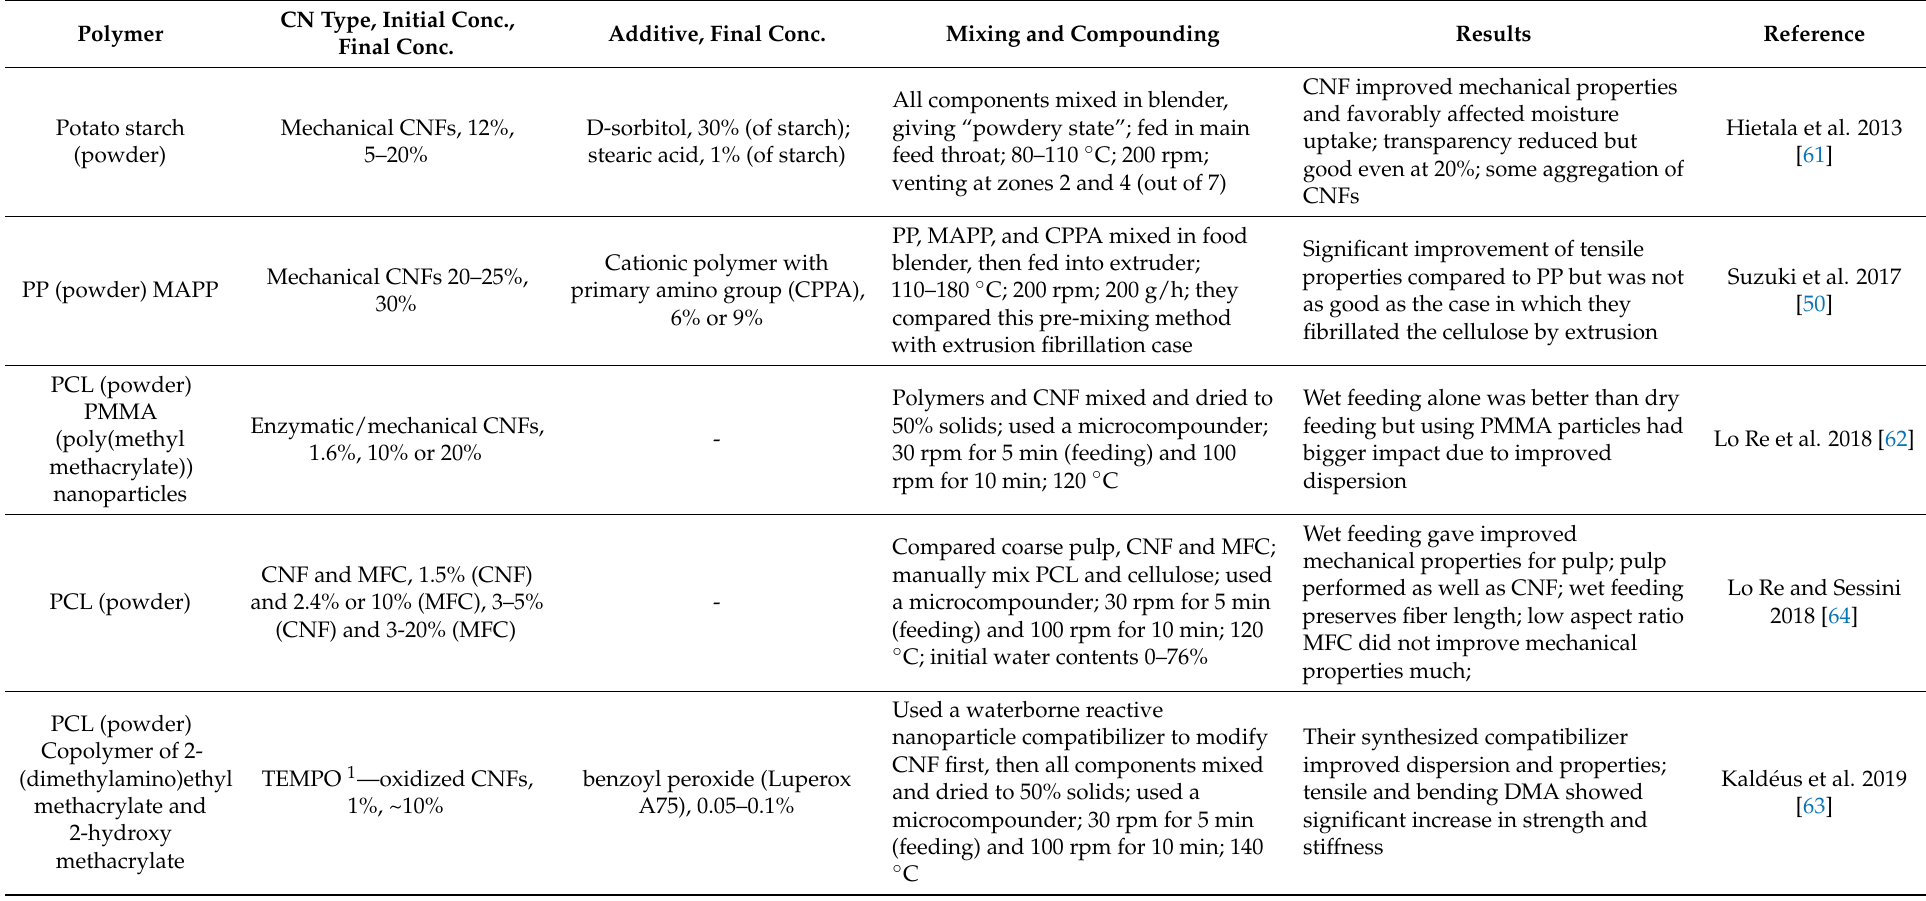
Table 3. Cellulose nanocomposites produced by pre-mixing CN suspensions with polymer powders followed by wet extrusion